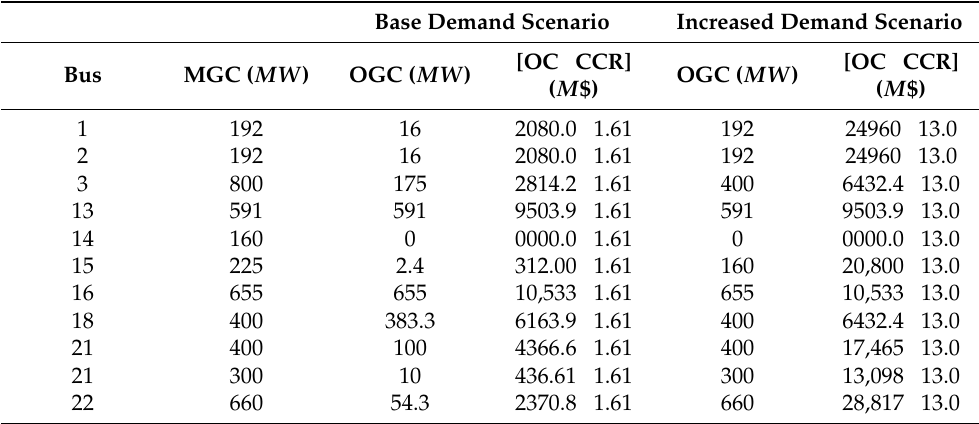
Table 12. Result of the base year optimal generation capacity versus optimal generation capacity with demand increase in a 39-bus system.